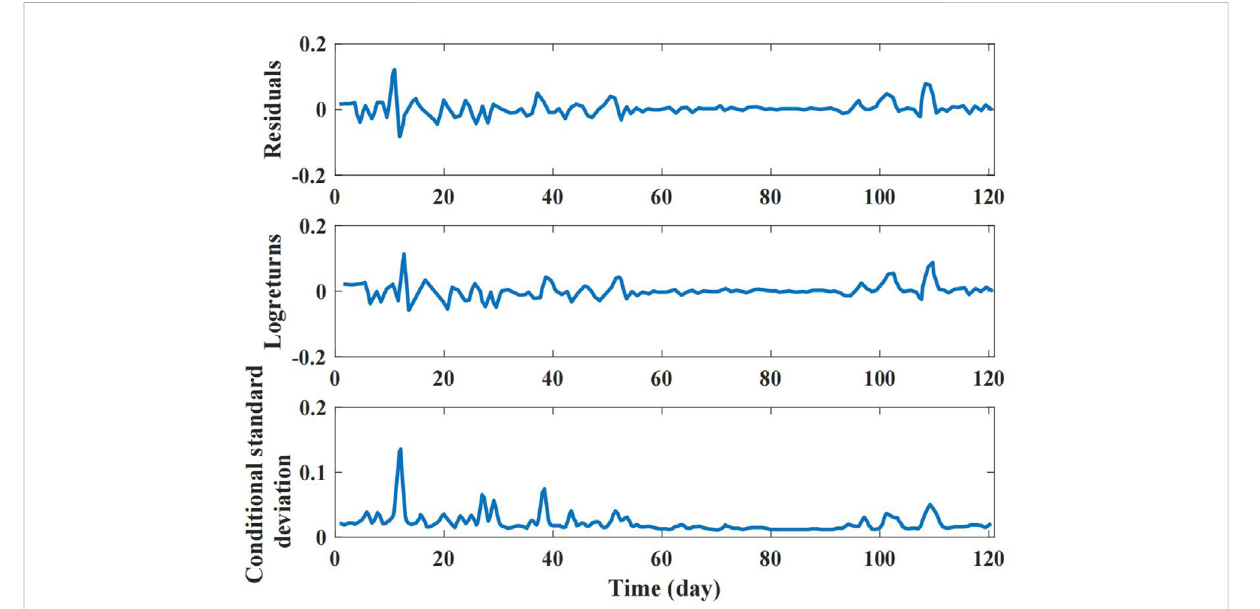
FIGURE 4 Residuals, logreturns and conditional standard deviation of the model in the estimation phase.